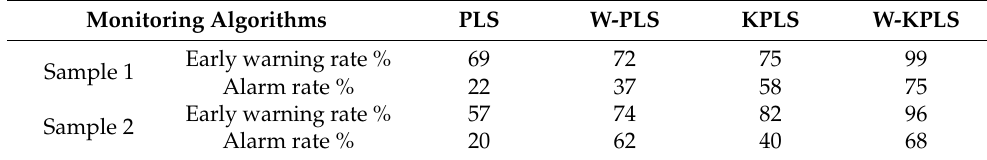
Table 5. Statistics of fault detection rate.